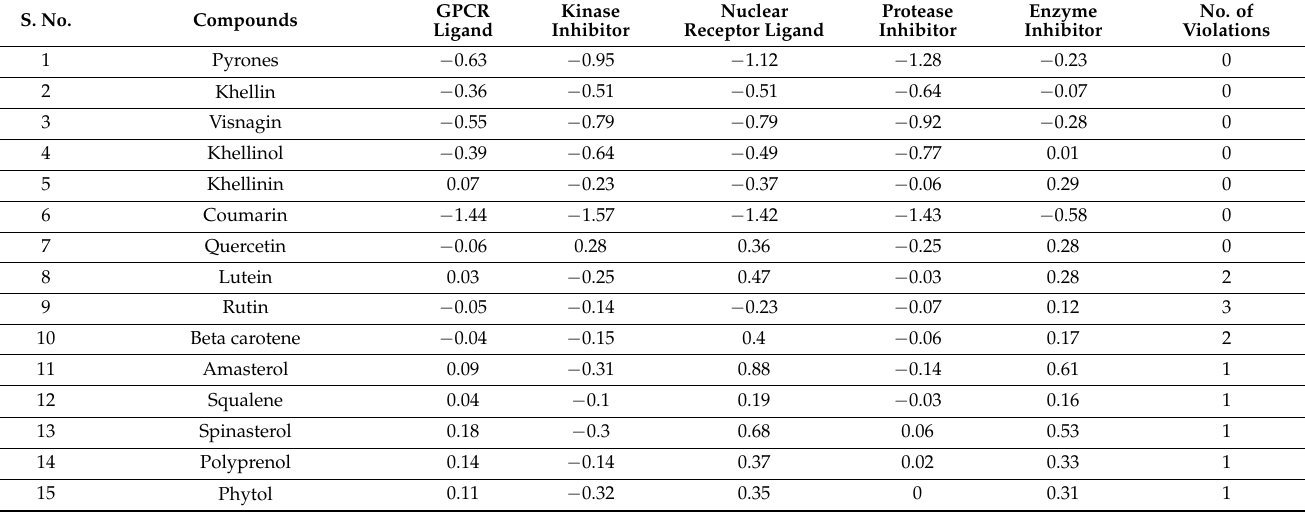
Table 3. Bio-properties of